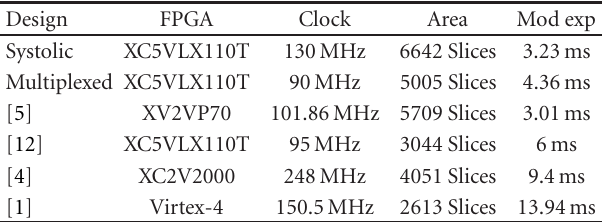
Table 3: State-of-art implementations of modular multiplication